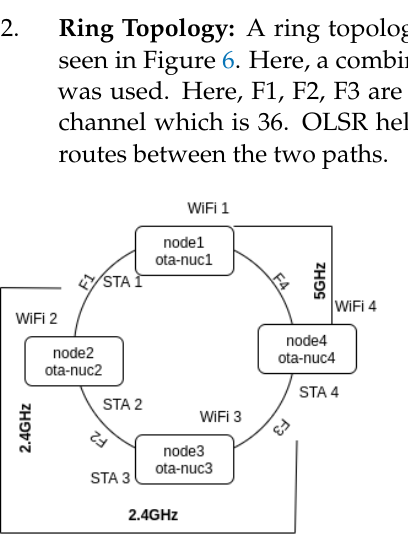
Figure 6. POWDER ring topology node